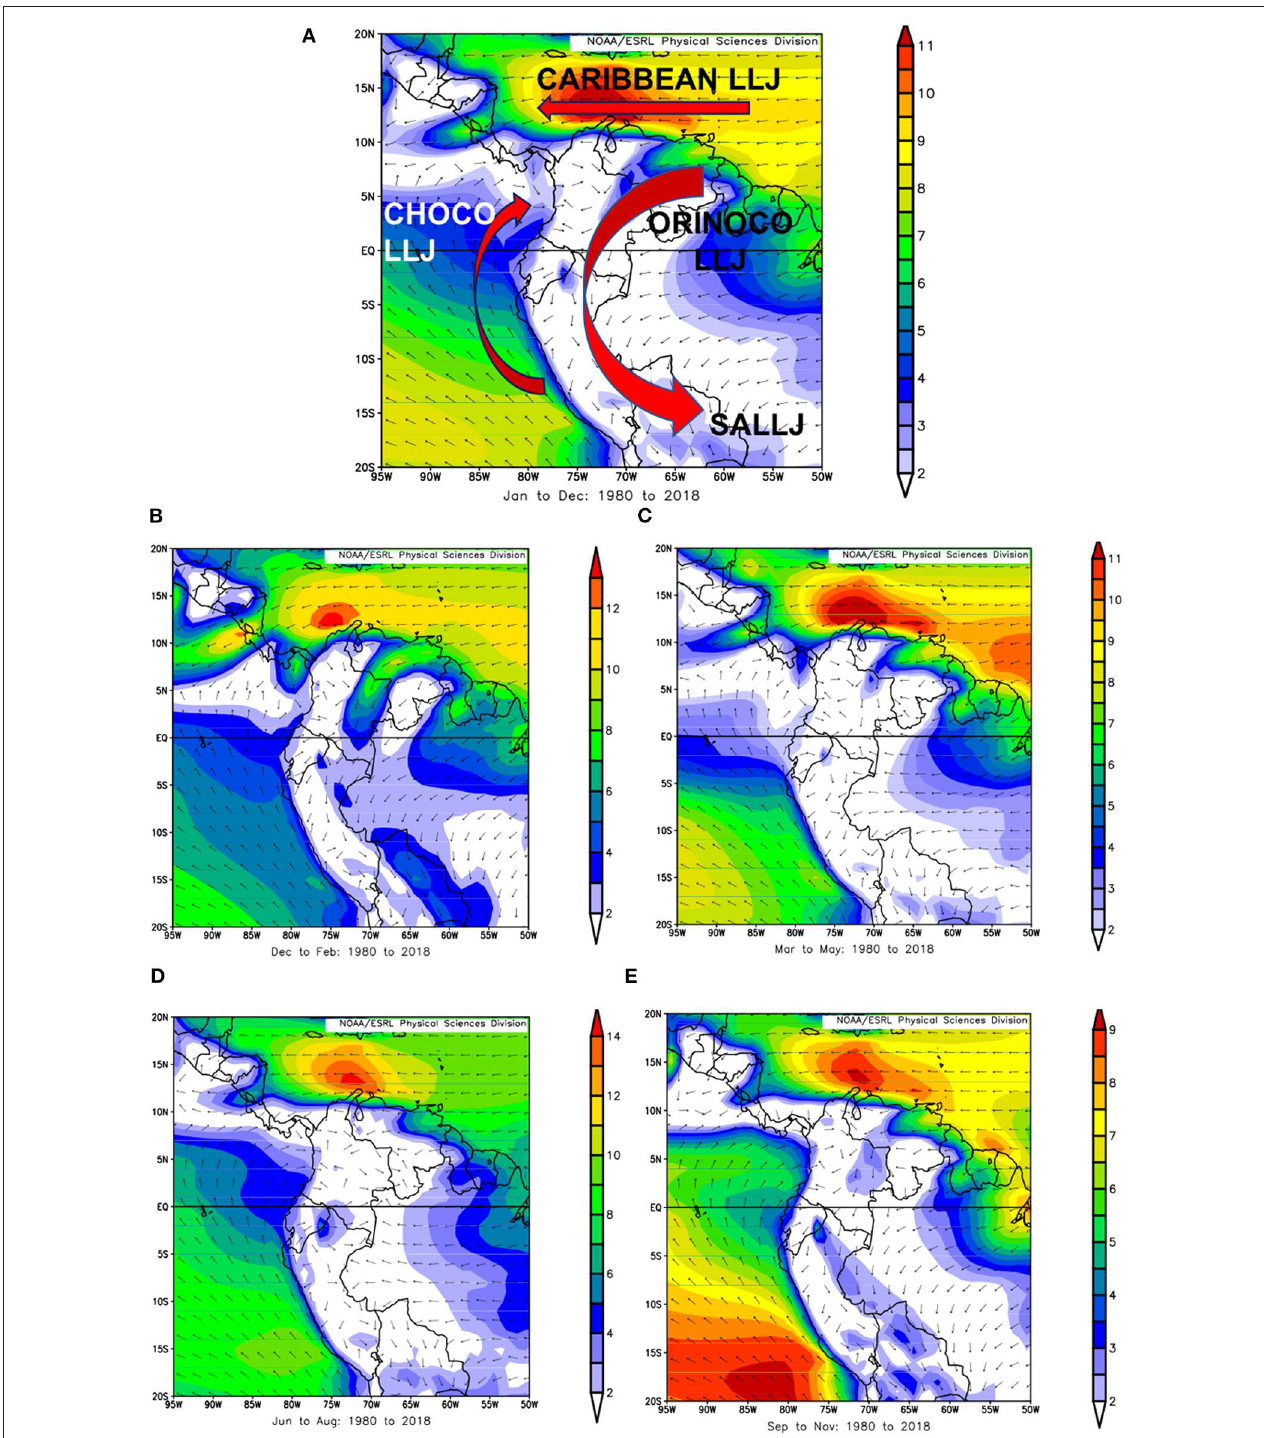
FIGURE 3 | Distribution of the long-term mean (1980-2018) horizontal wind speed (m/s) at 950 hPa over northern South America; (A) Mean annual values showing the Choco, Caribbean, and Orinoco low-level jets, and the SALLJ. Mean seasonal values during (B) December-January-February; (C) March-April-May; (D) June-July-August; and (E) September-October-November. Images prepared from the NOAA/ESRL Physical Sciences Division, Boulder Colorado; https://www.esrl. noaa.gov/psd/.